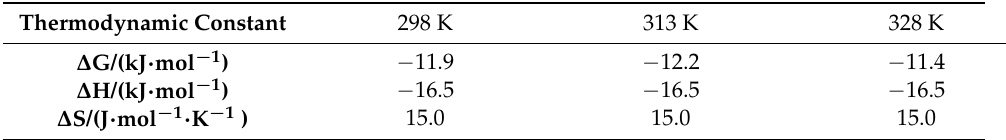
Figure 12. Thermodynamic calculation fitting of adsorption. Table 4. Thermodynamic constants of phosphorus adsorption on composite adsorbents at different